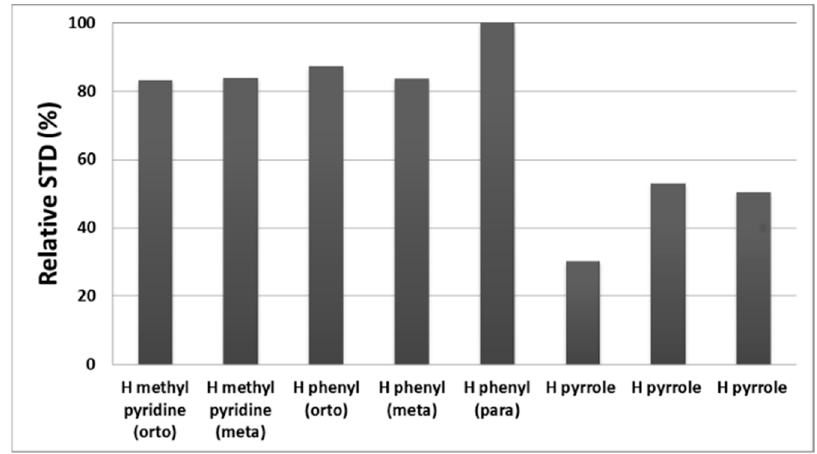
Figure 7. Relative intensity of STD signals of the individual protons for Tris-T4 normalized to that of the most intense not overlapped signal.